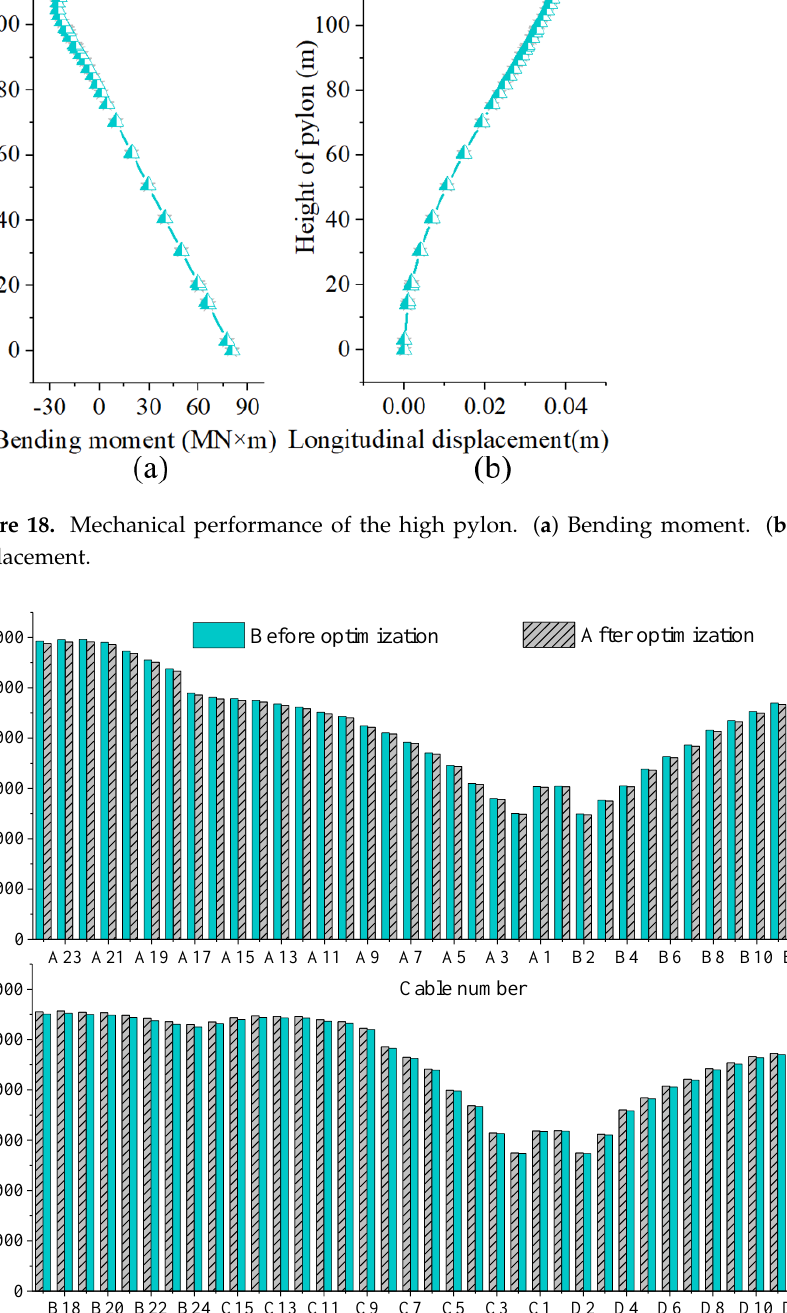
Figure 19. Cable tension of the stay cables.